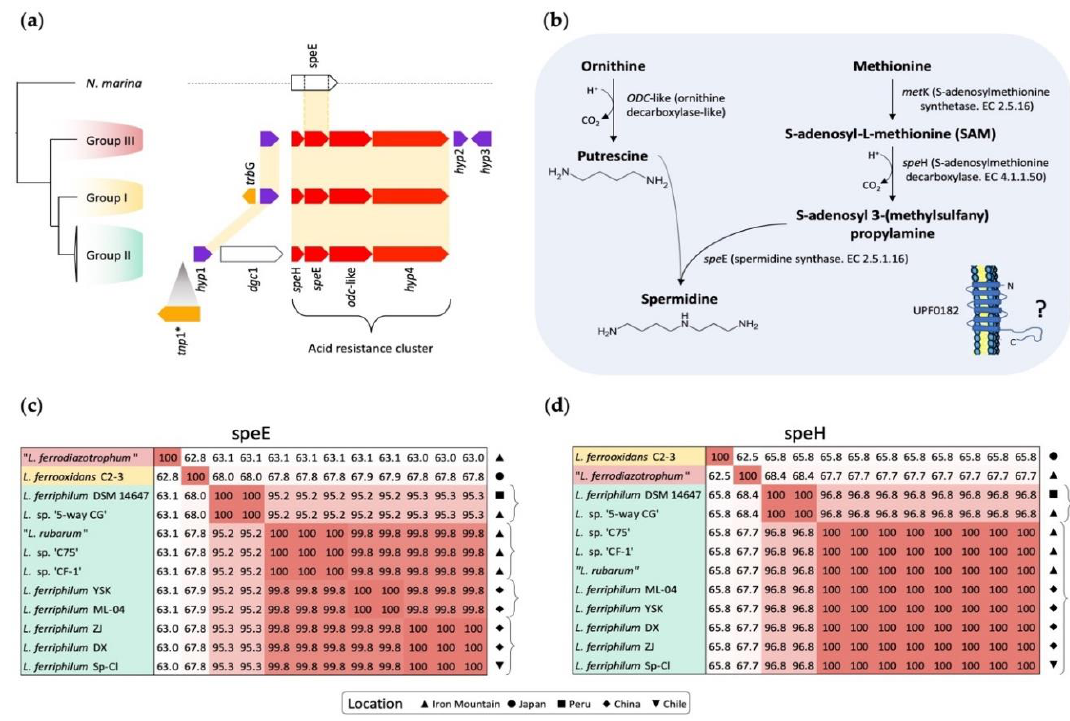
Figure 4. ( a,b ) Predicted spermidine biosynthesis genes and pathways of Leptospirillum . ( a ) Phylogenetic distribution and genomic contexts of spermidine biosynthesis genes. Color coding of genes: red = spermidine biosynthesis genes, purple = orphan hypothetical genes, orange = mobile elements and their remnants. * tnp 1 was observed only in strain “CF-1” of Group II. ( b ) Predicted functions of the spermidine biosynthesis genes. ( c,d ) Heat maps of the nucleotide sequence identity of spe E ( c ) and spe H ( d ) in Leptospirillum . Red coloring indicates 100% nucleotide sequence identity, and numbers indicate the percent nucleotide identity.